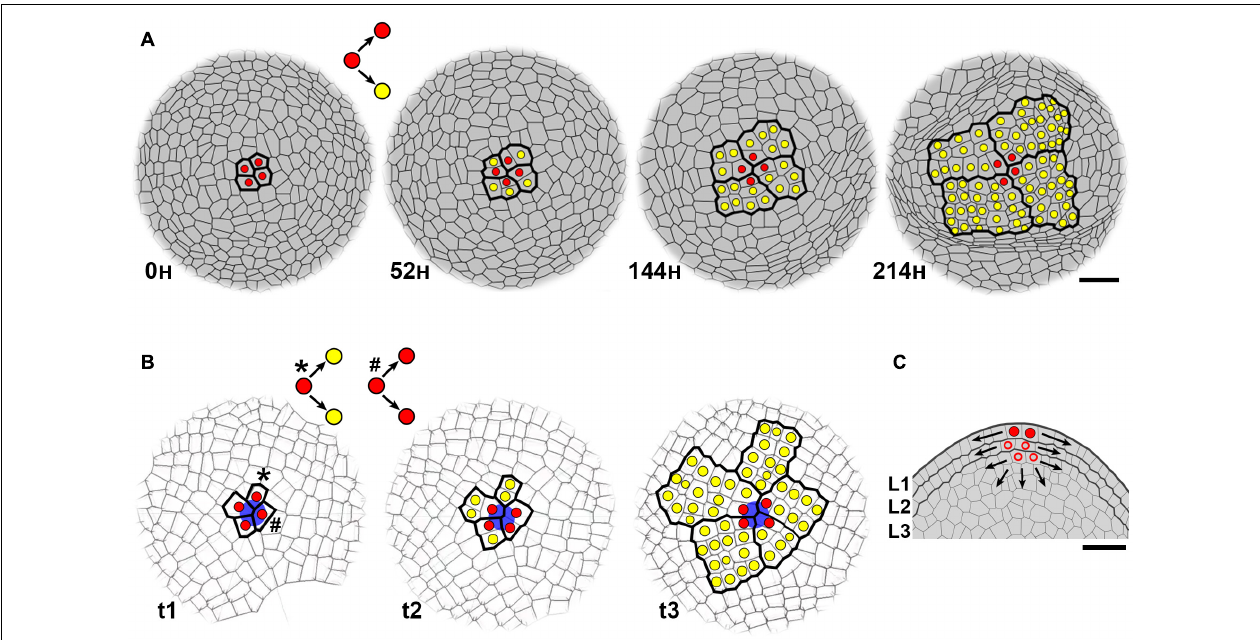
FIGURE 2 | Stochastic and semi-permanent behavior of plant stem cells. (A) Dynamics of stem cells at the surface of vegetative SAM in Arabidopsis (top view, based on the figure 4, Burian et al., 2016). Stem cells were identified at L1 (the outermost cell layer of tunica) by tracing of cell lineages based on time-lapse imaging with laser confocal microscopy. A stem cell (red) divides asymmetrically producing the descendant cell that maintains its position at SAM center and stem cell fate, and the cell that loses stem cell fate by its displacement to the periphery, and becomes transit-amplifying cell (yellow) undergoing series of cell divisions. Note, that the same set of four stem cells is functioning for at least 9 days. Scale bar, 20 µ m. (B) Computer simulation of stochastic stem cell behavior (modified, based on the Video S4, Kucypera et al., 2017). In Kucypera et al. (2017), stem cells were defined by a stable point corresponding to the geometric center of SAM surface. Here, stem cells (red) were defined at t1 by a stable positional information marked by a blue circle. The simulation shows that although these stem cells generally divide asymmetrically, symmetrical divisions can also occur leading to rearrangement of stem cells. Due to cell displacement, both descendants of the stem cell (indicated by an asterisk at t1) lose stem cell fate at t2, and undergo series of cell divisions (yellow). Consequently, the cell clone is displaced from the SAM center at t3. In contrast, both descendants of the other stem cell (indicated by a hash at t1) keep stem cell fate at t2 as they maintain the position at the center. (C) Plausible stem cells below SAM surface. At longitudinal section across the SAM (from A ), thicker lines indicate outer cell layers of the tunica (L1 and L2) and inner corpus (L3). Arrows indicate the direction of cell displacement due to oriented cell divisions. Each tunica layer and the corpus contain their own sets of stem cells. Red circle, stem cell of the L1 (identified at A ), empty circle, plausible stem cells of L2 and L3. Stem cells of L1 give rise to epidermis, L2 – subepidermal tissues, and gametes, L3 – internal tissues. Scale bar, 20 µ